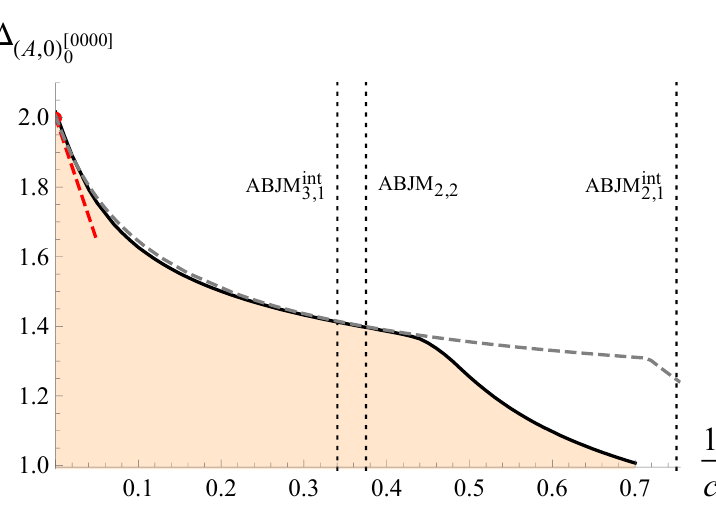
(left) and (cid:21) 2 (right) OPE coe(cid:14)cients, ( B; +) [0050] 5 ( A; +) [0030] 5 2 ; 0 2 ; 0 with 16 = (cid:25) (cid:0) 3 (cid:24) : 34 and ABJM int with 16 = 3 . 3 ; 1 2 ; 1 c T 10 (cid:25) (cid:0) 31 c T 4